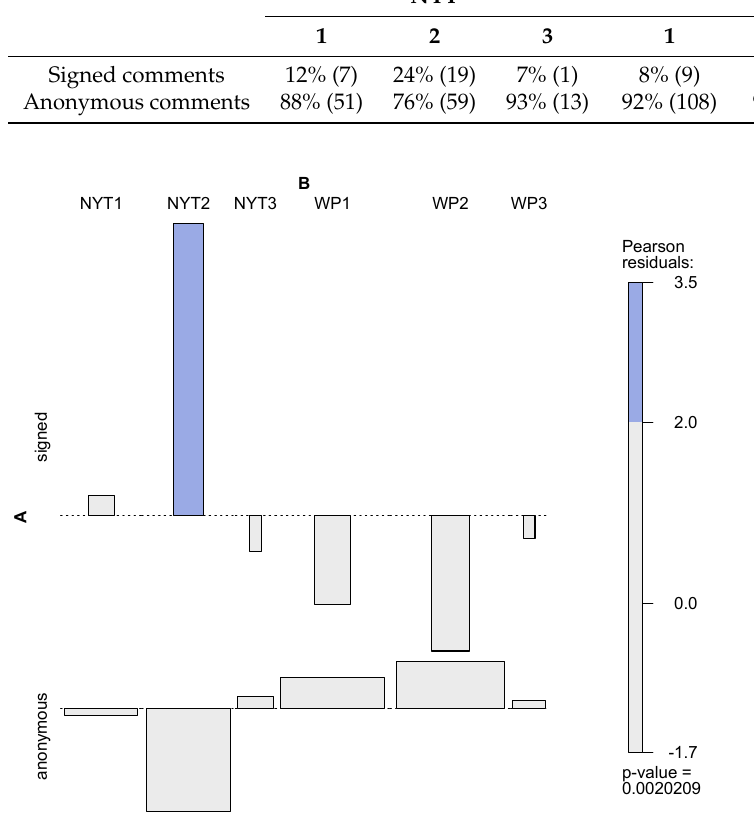
Figure 3. The Cohen-Friendly graph of Table 4 shows that toxic comments directed at others (including public figures) are more associated with signed comments ( p < 0.01) in the New York Times.